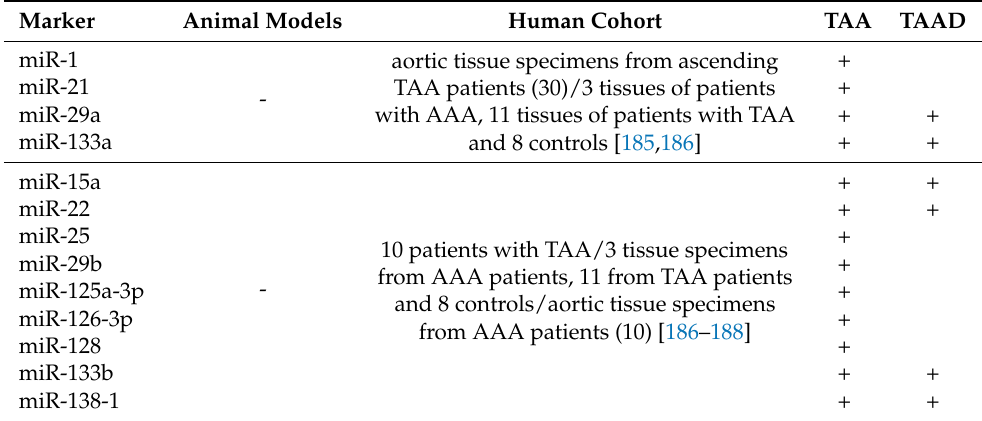
Table 3. Novel potential circulating biomarkers for TAAD.